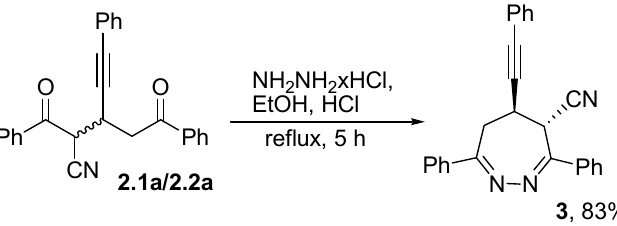
Scheme 3. Reaction of δ -diketones 2.1a / 2.2a with hydrazine leading to diazepine 3